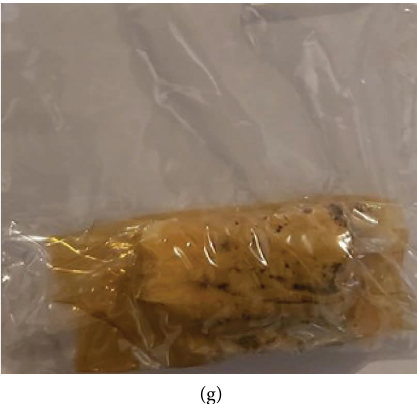
Figure 5: Visual appearance of noninoculated and inoculated bread after 60days storage at 25 ° C. (a) noninoculated baguette, (b) noninoculated sandwich-type bread, (c) inoculated toast, (d) inoculated baguette, (e) CH-BCNF inoculated baguette, (f) inoculated sandwich-type bread, and (g) CH-BCNF inoculated sandwich-type